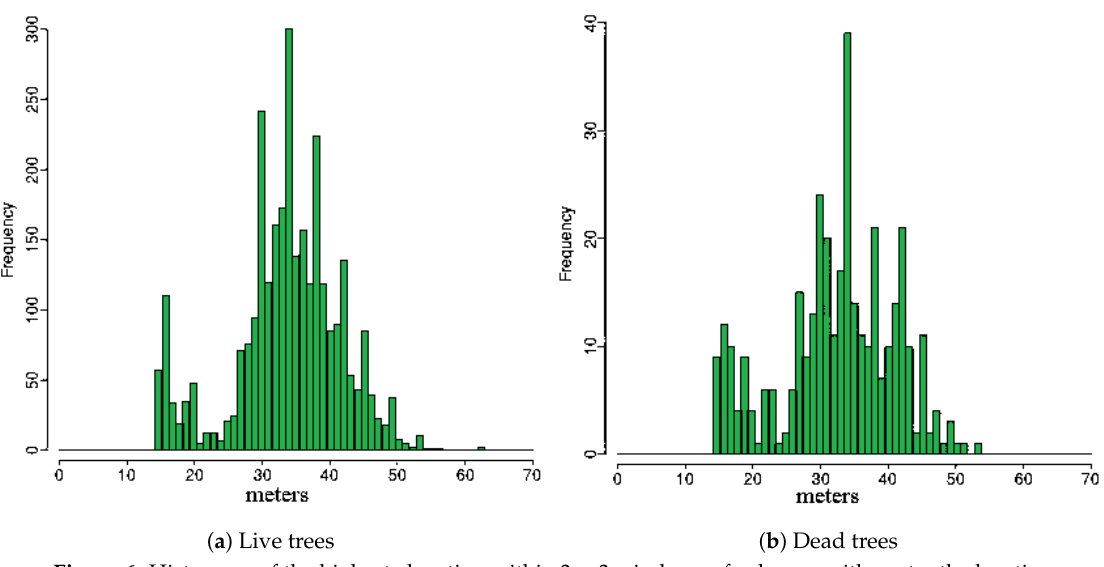
Figure 6. Histogram of the highest elevation within 3 × 3 windows of columns with centre the location of trees listed within the field data. Histogram ( a ) includes the heights of the Live Trees and histogram ( b ) the heights of the dead